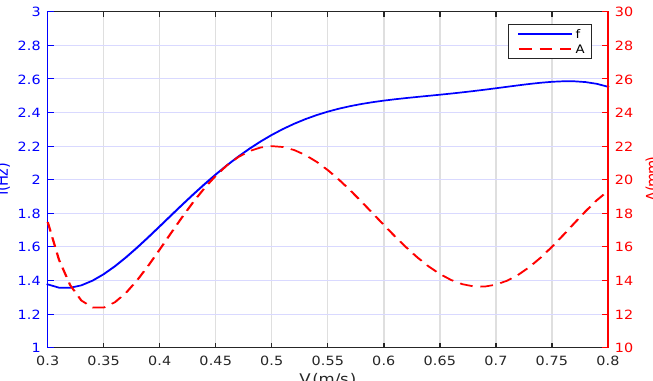
Figure 4. Waveform parameters to the swimming speed.